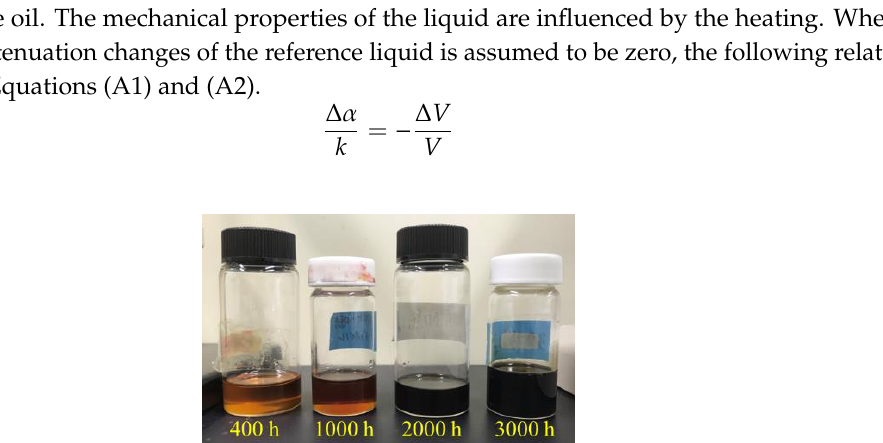
( b ) Figure 7. Evaluation of the electrical property changes of ( a ) iron and ( b ) carbon powders in new engine oil using the relative permittivity – conductivity chart. The arrow shows the direction of time. The results of olive oil and new and used engine oils are also plotted in the figure. (*: 1 × 10 − 8 (S/m)/Hz). 3.3. Influence of the Heating The operating temperature of the engine is high, hence, engine oil is influenced by temperature.